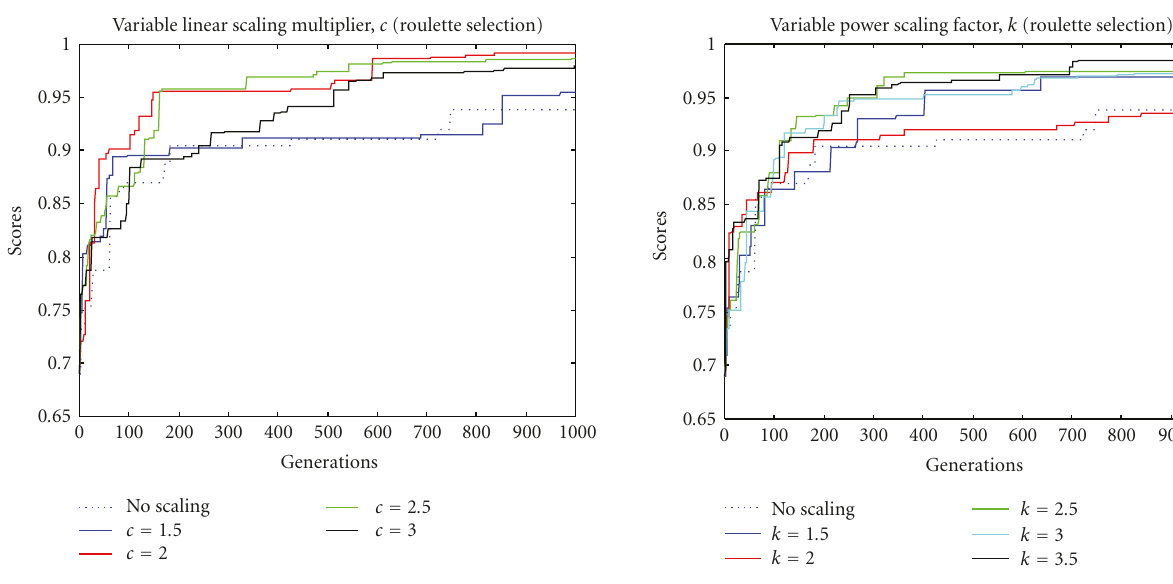
Figures 12 to 16 show the optimization processing of base station displacements. Figure 12 shows the initial random location of the base stations, and in this case five base stations have covered 69% of the target area. In Figure 13, seven base stations have covered 92% of target area with uniform selection, but it is still not optimized. Figure 14 is the result of a roulette-wheel selection, and this is an improvement over the uniform selection. It covers 93.85% of the target area. The rank selection covers 97.90%; this is a very good result. The tournament selection o ff ers 99.78% coverage. This is approximately at the optimization level. As fitness is sensitive in terms of selection schemes, optimization processing needs appropriate selection